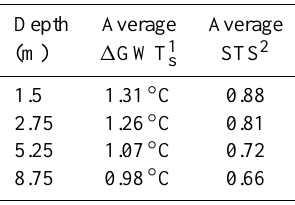
Table 4. Simulated summer subsurface thermal sensitivities for each depth, averaged for the seven climate